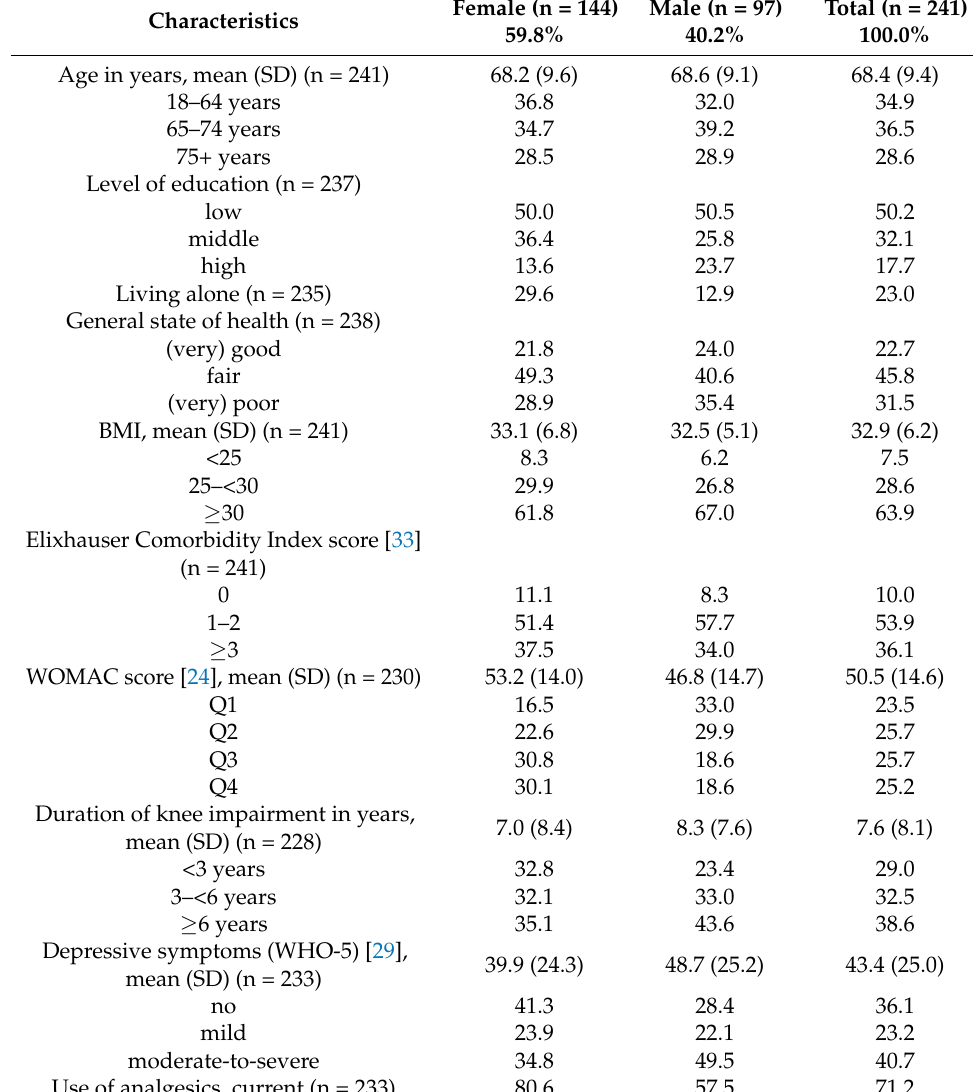
Table 1. Characteristics of the study population in